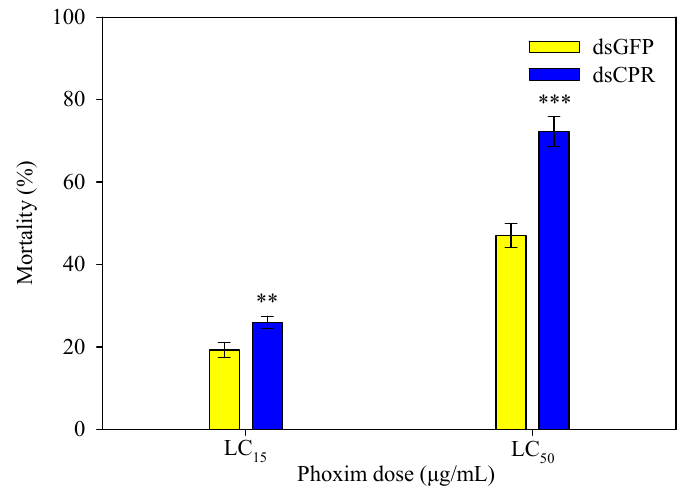
Figure 6. Effect of SlCPR silencing on the susceptibility to phoxim. Fourth-instar larvae were microinjected with dsCPR or dsGFP (control). Thirty fifth-instar larvae were then exposed to phoxim at LC 15 (4 μ g/mL) or LC 50 (20 μ g/mL) doses for 48 h. All tests were performed in triplicate. Data shown are mortality rates (means ± SE). Asterisks indicate significant differences between SlCPR -silenced larvae as compared to the control group (Student’s t -test, ** p < 0.01, *** p < 0.001).